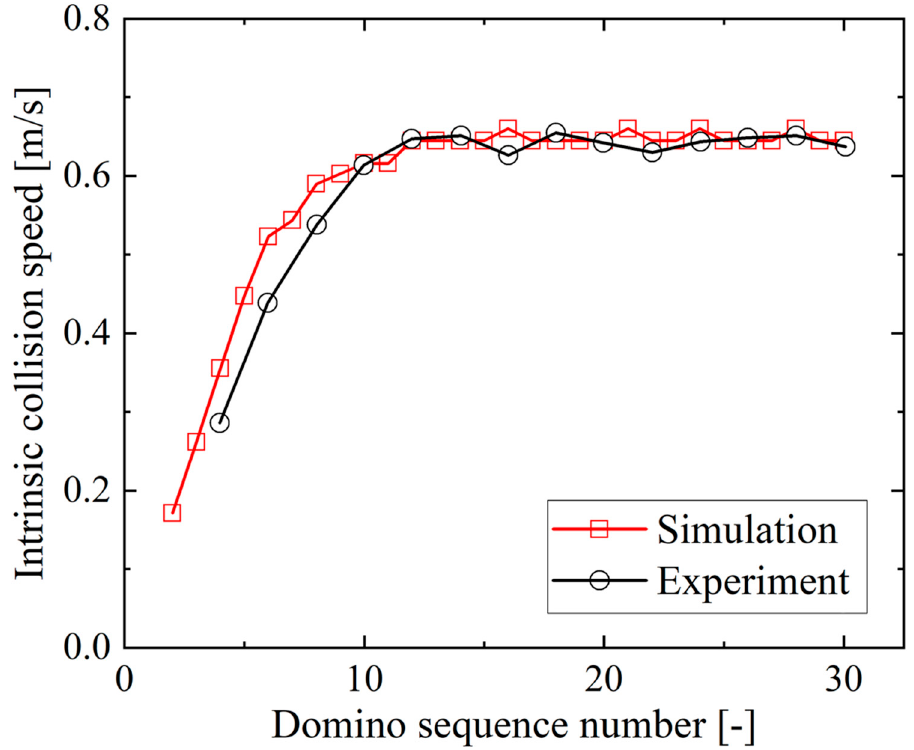
Figure 4. Comparison of the domino wave speed. Black line: experimental results [26]; red line: numerical results.